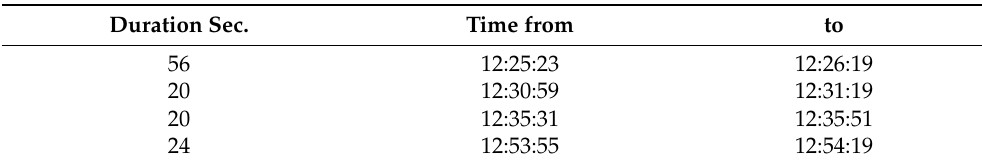
Figure 3. Midday nap of the patient with subsiding pneumonitis until shortly before 13:00 h without oxygen supply, then with oxygen supply 1.5 L/min. Table 2. Falling below the threshold value 1 of the oxygen concentration in the blood by 1% during the Midday sleep from Figure